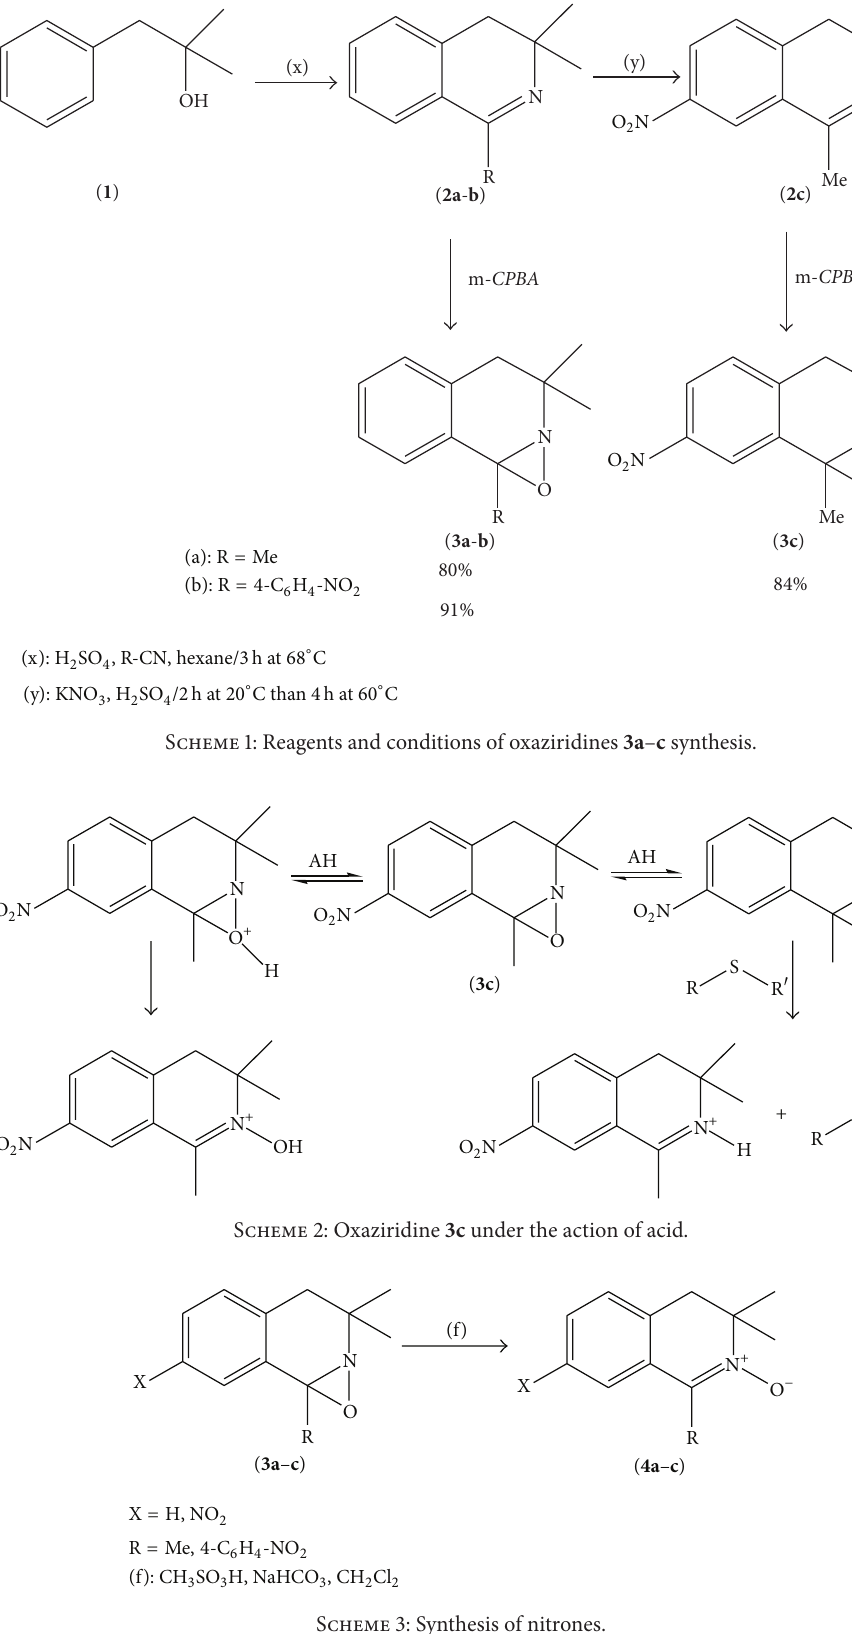
Scheme 3: Synthesis of